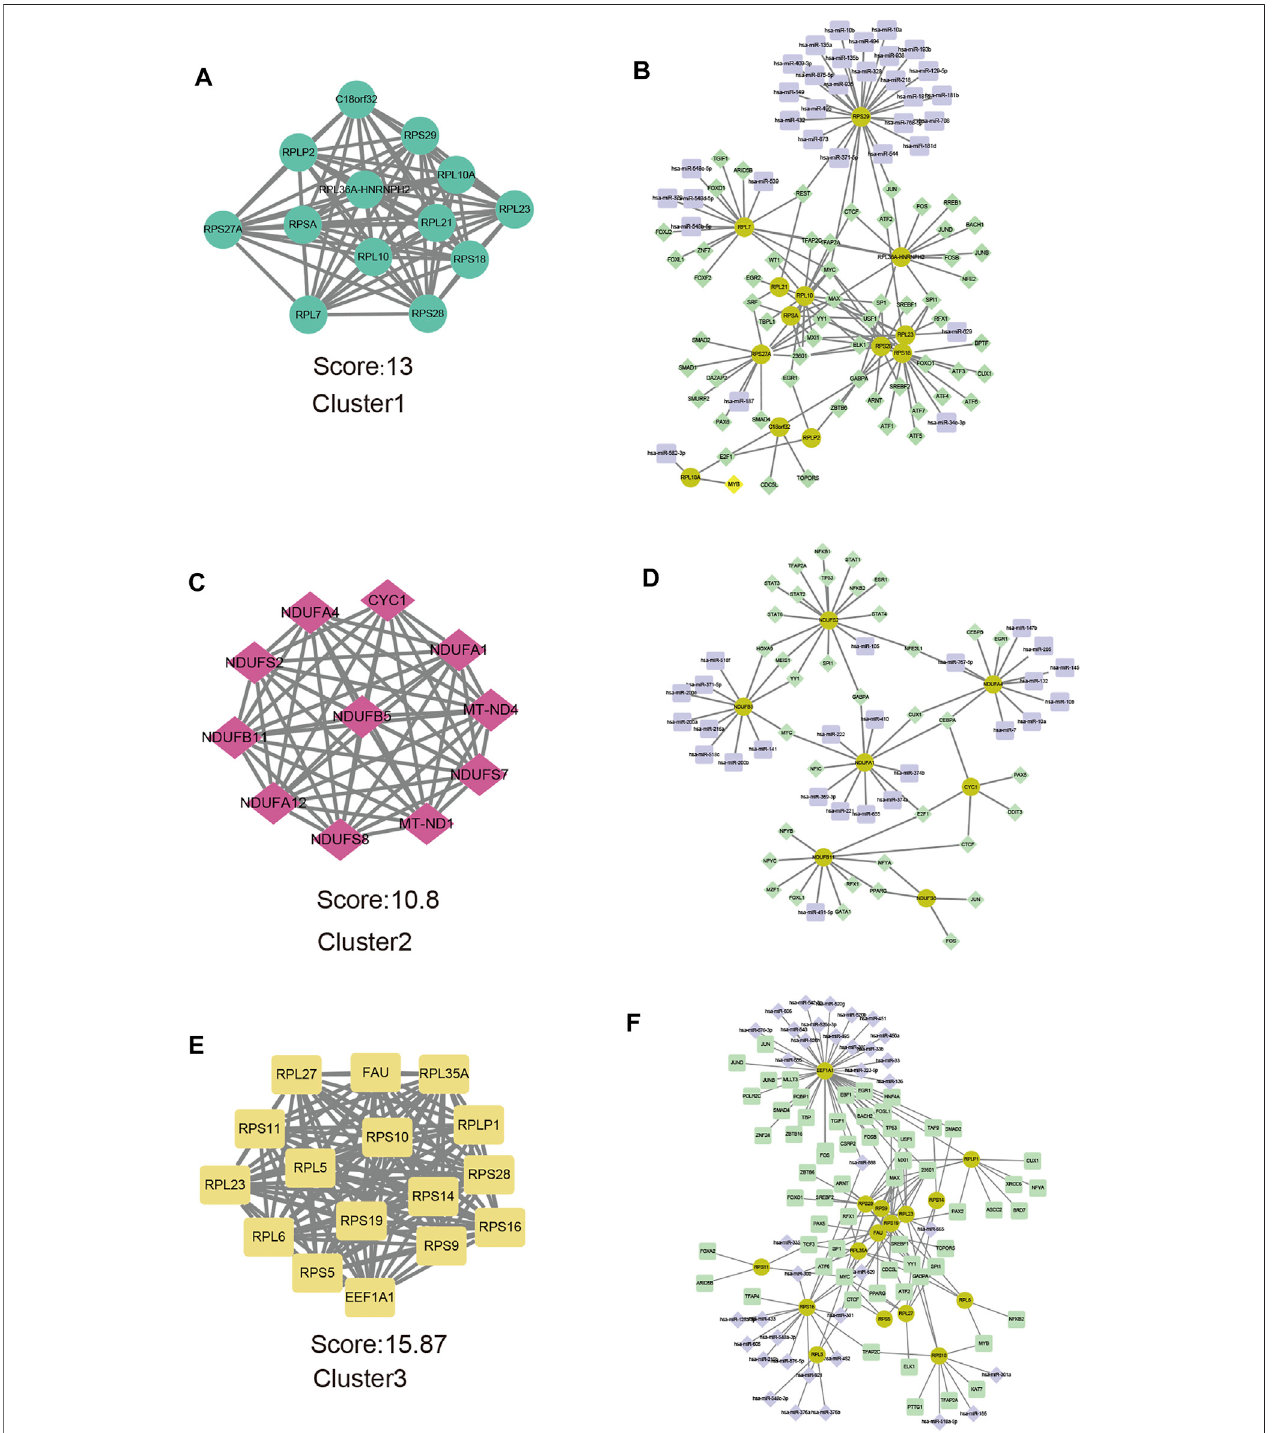
FIGURE 8 | Hub genes analysis and miRNA-TF coregulatory networks of representative genes of each subtype. Modules with the highest MCODE scores from representativegenesofcluster1 (A) ,cluater2 (C) andcluster3 (E) areillustrated.Networksforhub-genesmiRNA-TFinteractionwithrepresentativegenesofcluster1 (B) , cluater2 (D) , and cluster3 (F) are shown. The highlighted yellow color nodes represent the hub genes, purple color nodes represent the miRNA and green nodes represent TF-genes.